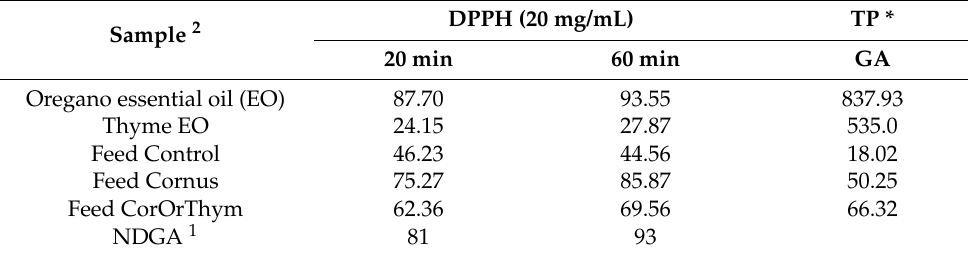
Table 4. Photometric analysis of oregano and thyme essential oils and sheep